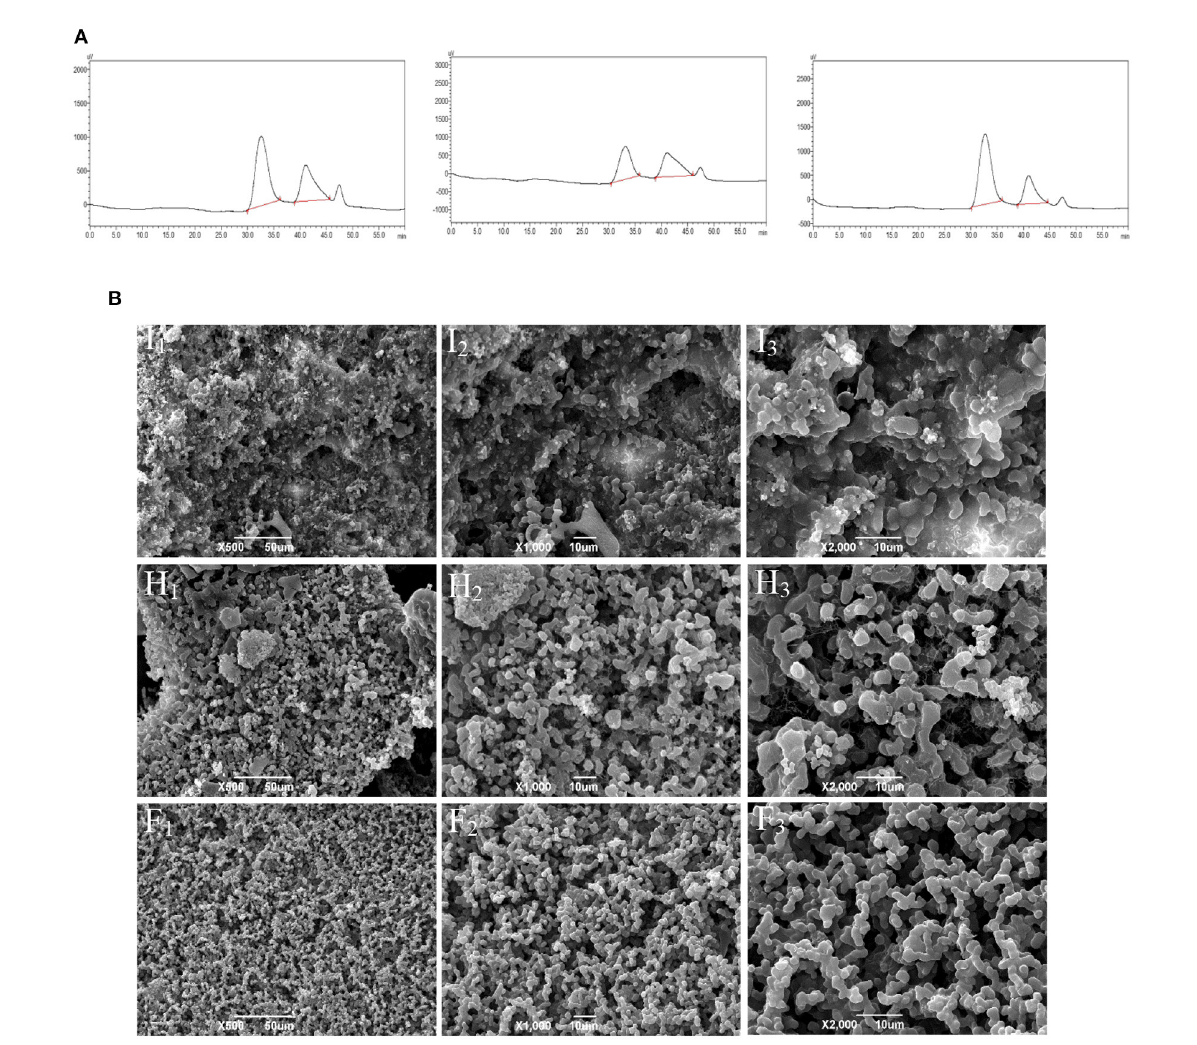
FIGURE1 Molecular weight profile and surface morphology of the polysaccharides from fruiting bodies of Cordyceps militaris under different drying treatments. (A) Molecular weight profiles of CMFPs. (B) SEM photomicrographs of CMFPs. (H) CMFP-H. (I) CMFP-I. (F)